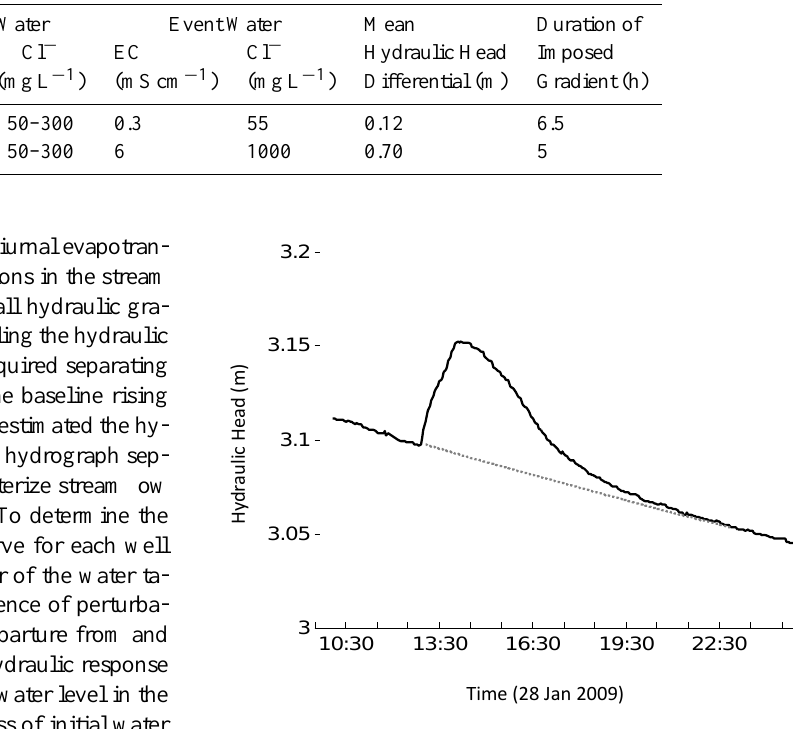
Fig. 4. An example hydraulic baseline (dotted line) approximated well response (solid line) in the absence of perturbation (well 3, no-salt